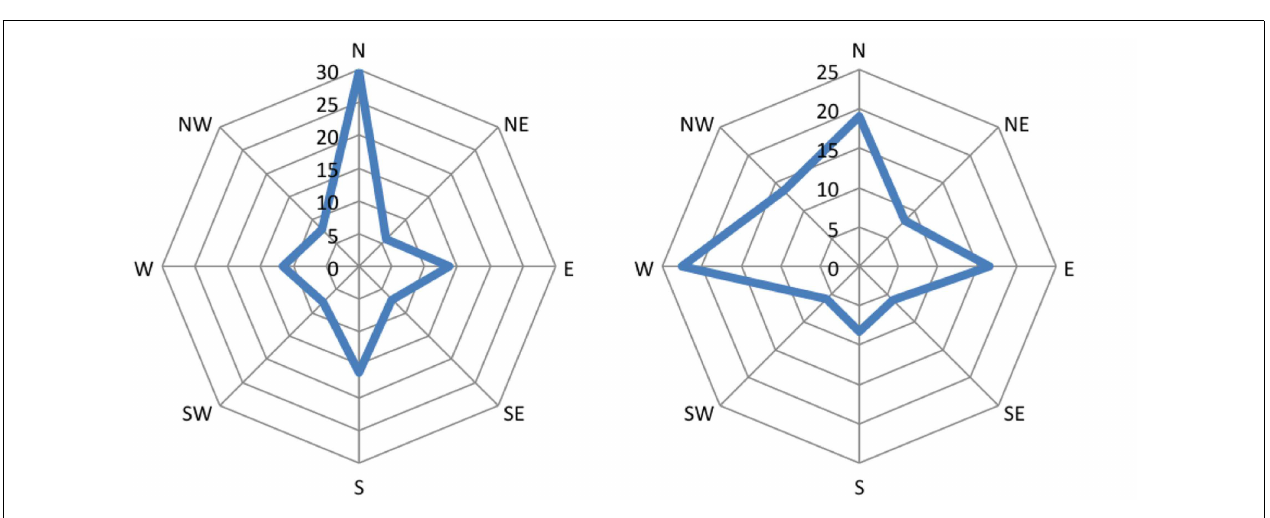
FIGURE 4 | Distribution of eye movements during first premises of the form “A is west of B.” Amplitude represents the percentage of saccades mapped onto the respective cardinal direction.